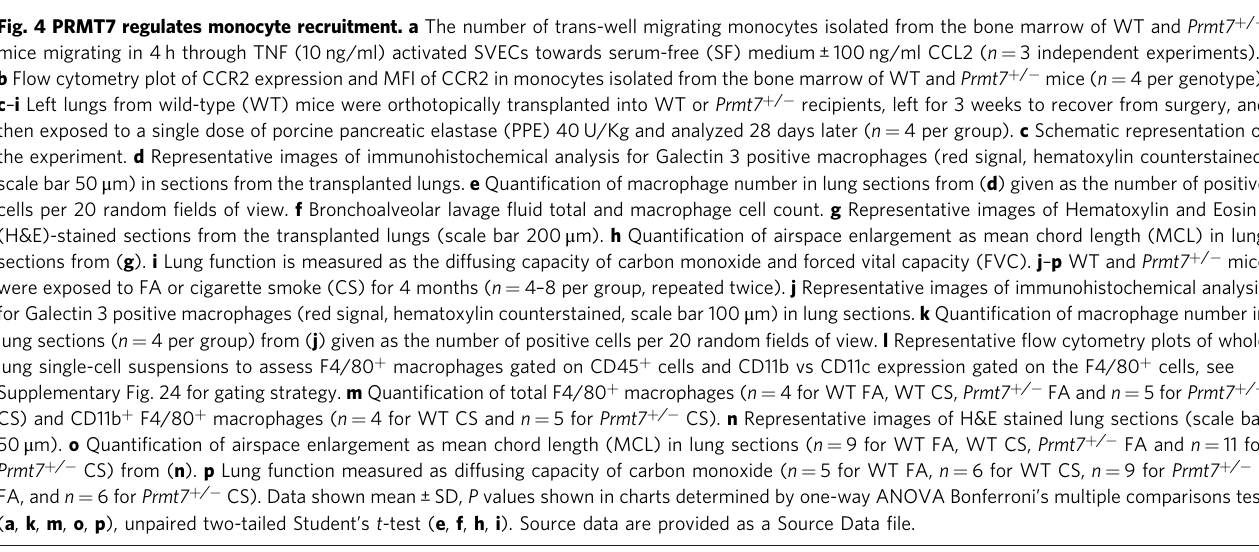
Supplementary Fig. 24 for gating strategy. m Quanti fi cation of total F4/80 + macrophages ( n = 4 for WT FA, WT CS, Prmt7 + / − FA and n = 5 for Prmt7 + / − CS) and CD11b + F4/80 + macrophages ( n = 4 for WT CS and n = 5 for Prmt7 + / − CS). n Representative images of H&E stained lung sections (scale